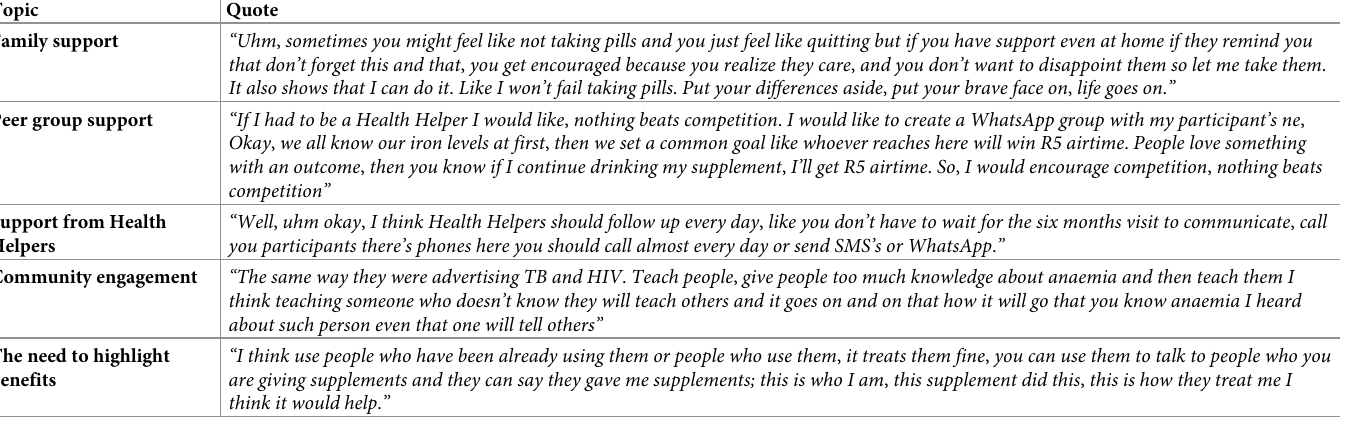
Table 5. Solutions from the